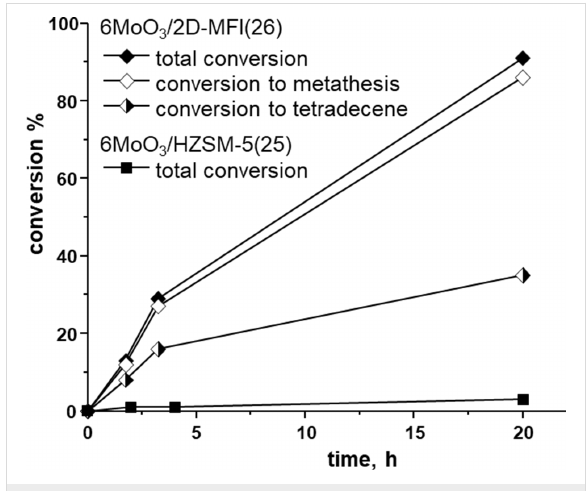
Figure 4: Conversion vs time curves for 1-octene metathesis over 6MoO 3 /2D-MFI(26) and 6MoO3/HZSM-5(25). Neat 1-octene, 1-octene/Mo = 320, t = 40